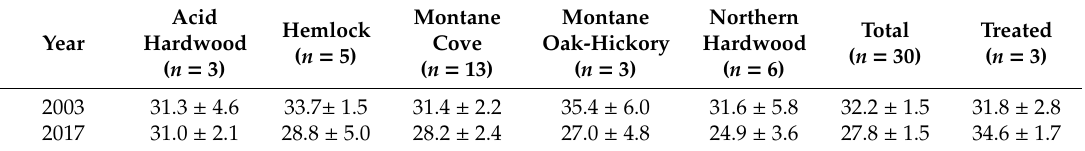
Table 1. Total basal area (m 2 ha − 1 ; mean ± SE) across ecogroups and chemically treated plots in 2003 and 2016 / 2017 (shown as 2017). Treated plots were not included in the calculations of total mean basal area across all